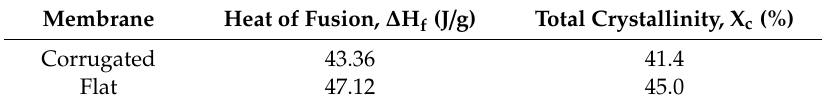
Table 3. Degree of crystallinity of the developed membranes based on Di ff erential scanning calorimeter testing.